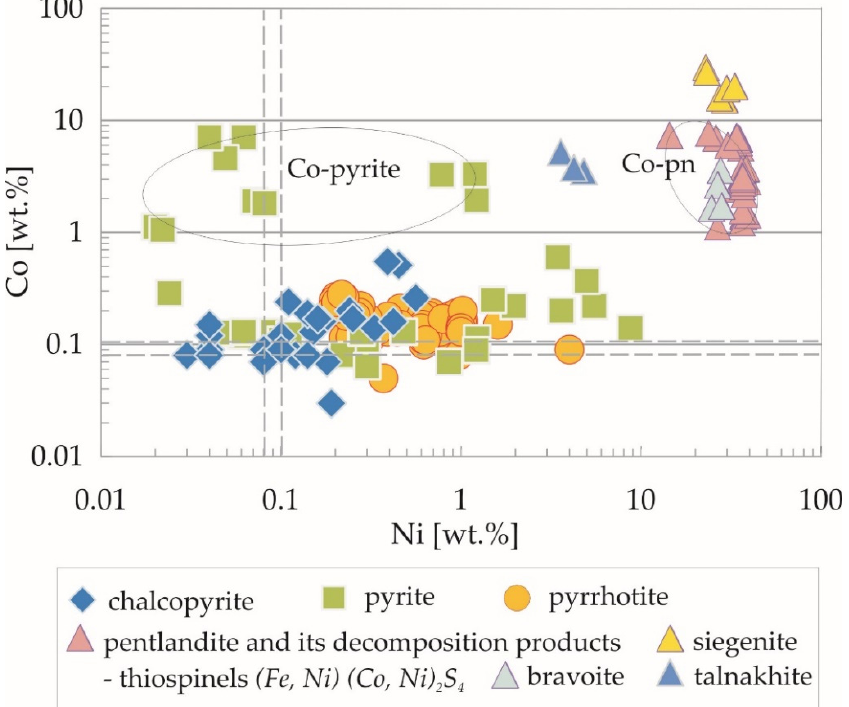
Figure 12. Bivariate diagram of Ni vs. Co in sulphides and thiospinels from the Udryn and Krzemianka Fe-Ti-V deposits. Zero values and values below low-precision limits are not presented on the logarithmic axis. Note: gray dashed lines indicate the range of precision of measurements in the entire population for a given element and sulphide.